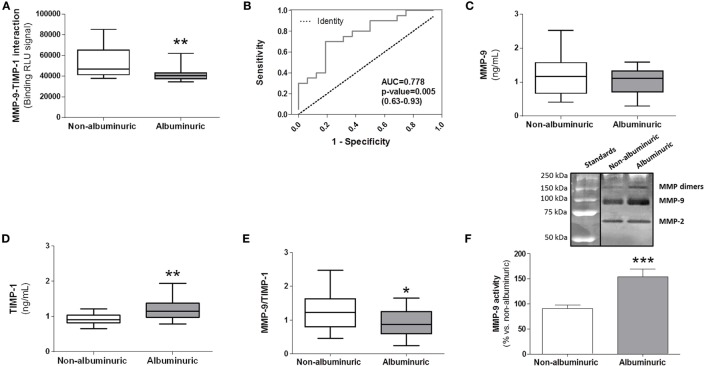
Comparison between specific matrix metalloproteinase (MMP)-9–tissue inhibitor of metalloproteinase (TIMP)-1 interactions determined by AlphaLISA® immunoassay and MMP-9, TIMP-1, and MMP-9/TIMP-1 ratio levels estimated by classical ELISAs in human plasma samples from hypertensive patients with normoalbuminuria versus albuminuria. (A) AlphaLISA® MMP-9–TIMP-1 interaction immunoassay expressed as binding RLU (relative luminescence units) in normoalbuminuric (n = 16) and albuminuric (n = 20) patients. (B) Receiver-operating characteristics curve for AlphaLISA® MMP-9–TIMP-1 immunoassay (AUC = 0.778, 95% CI 0.63–0.93). This curve was used for comparing the ability of the AlphaLISA® MMP-9–TIMP-1 immunoassay to predict albuminuria in hypertensive patients. AUC, area under curve; CI, confidence interval. (C) MMP-9 and (D) TIMP-1 levels quantified by standard ELISAs. (E) MMP-9/TIMP-1 ratio estimation. *P < 0.05, **P < 0.01, and ***P < 0.001 versus albuminuric patients. (F) Gelatinase MMP-9 activity in human plasma, upper panel, representative gelatin zymography gel, bottom panel, densitometric analysis expressed as % of change versus normoalbuminuria. In panels (A,C,D,E), results are expressed as median values (horizontal line) and the interquartile ranges (box). In panel (F), results are expressed in bar graph as mean values ± SEM.